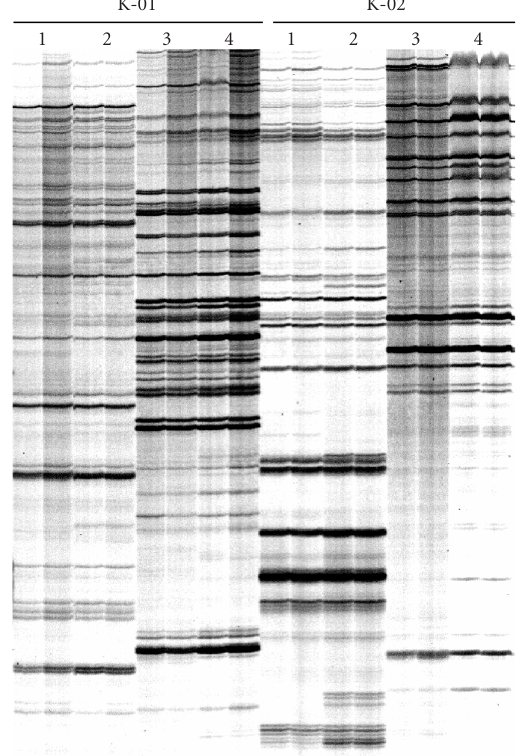
Figure 2. RAF profiles amplified from genomic DNA and alkali-treated leaf tissue. Lanes 1 show the profiles from replicate DNA extractions from a sug- arcane seedling, and lanes 2 show the profiles from replicate alkali-treated leaf tissue samples from the same seedling. Similarly, lanes 3 show the pro- files from genomic DNA extractions of a tomato plant, and lanes 4 show the profiles from alkali-treated leaf tissue samples from the same plant. The Operon oligonucleotide primers used are listed above the lanes.